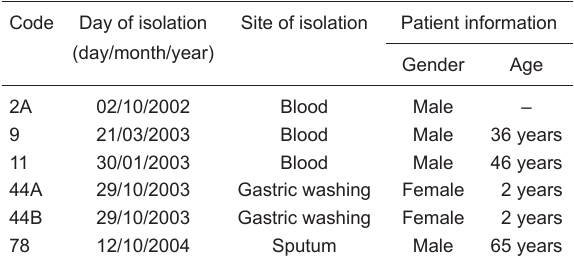
Table 1. Characteristics of fluconazole/itraconazole trailing strains of Candida albicans used in this study.